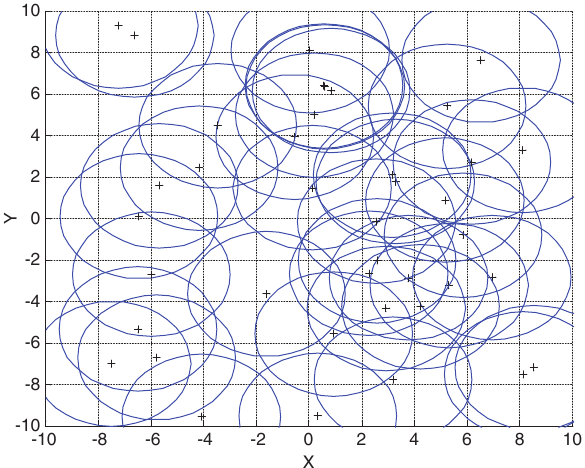
Figure 17: The Node Layout When the Number of Nodes Was